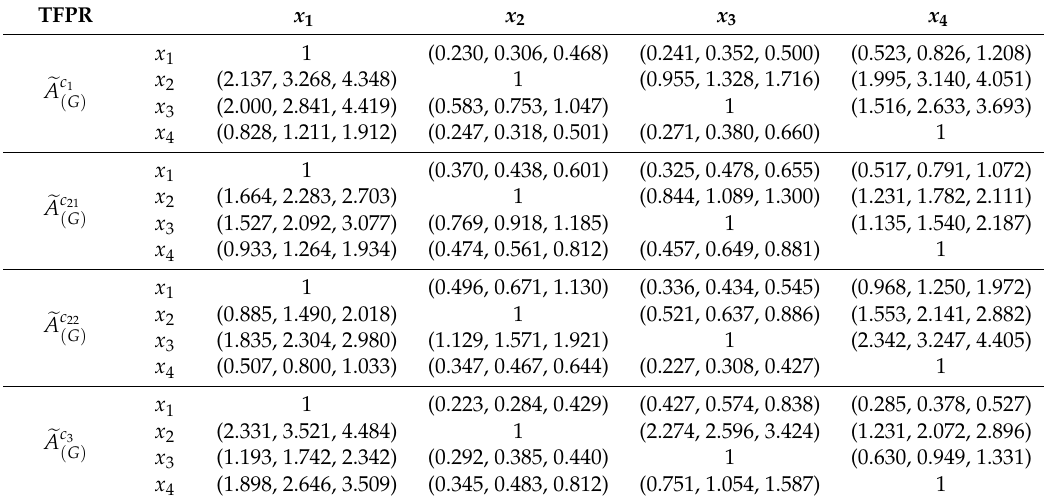
Table 6. The obtained group triangular fuzzy judgments.